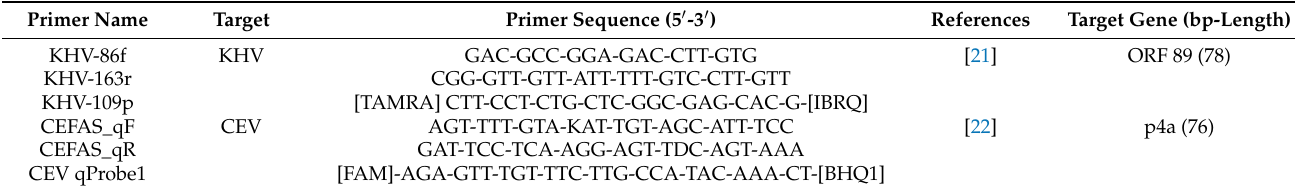
Table 3. List of oligonucleotides used during this